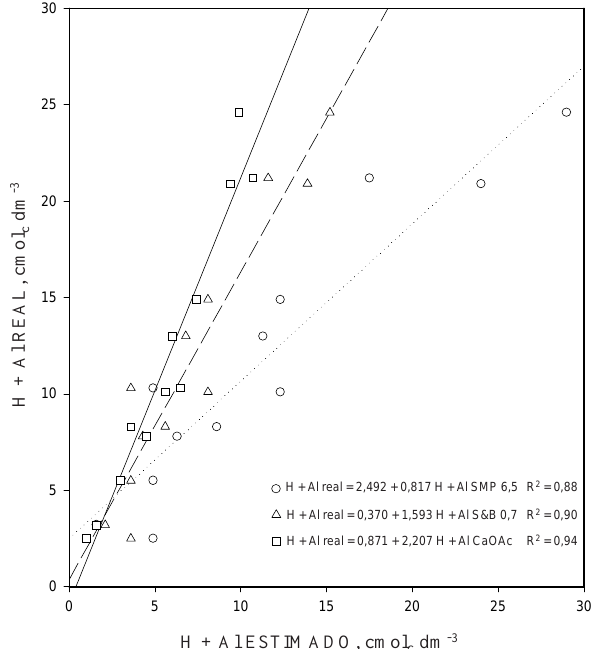
Figura 1. Equações de regressão entre a acidez potencial real dos solos a pH 7,0 (H + Al) e a acidez estimada pelo extrator acetato de cálcio (CaOac.), equação de Escosteguy e Bissani (S&B) e pela estimativa da necessidade de calcário pelo índice SMP para pH 6,5